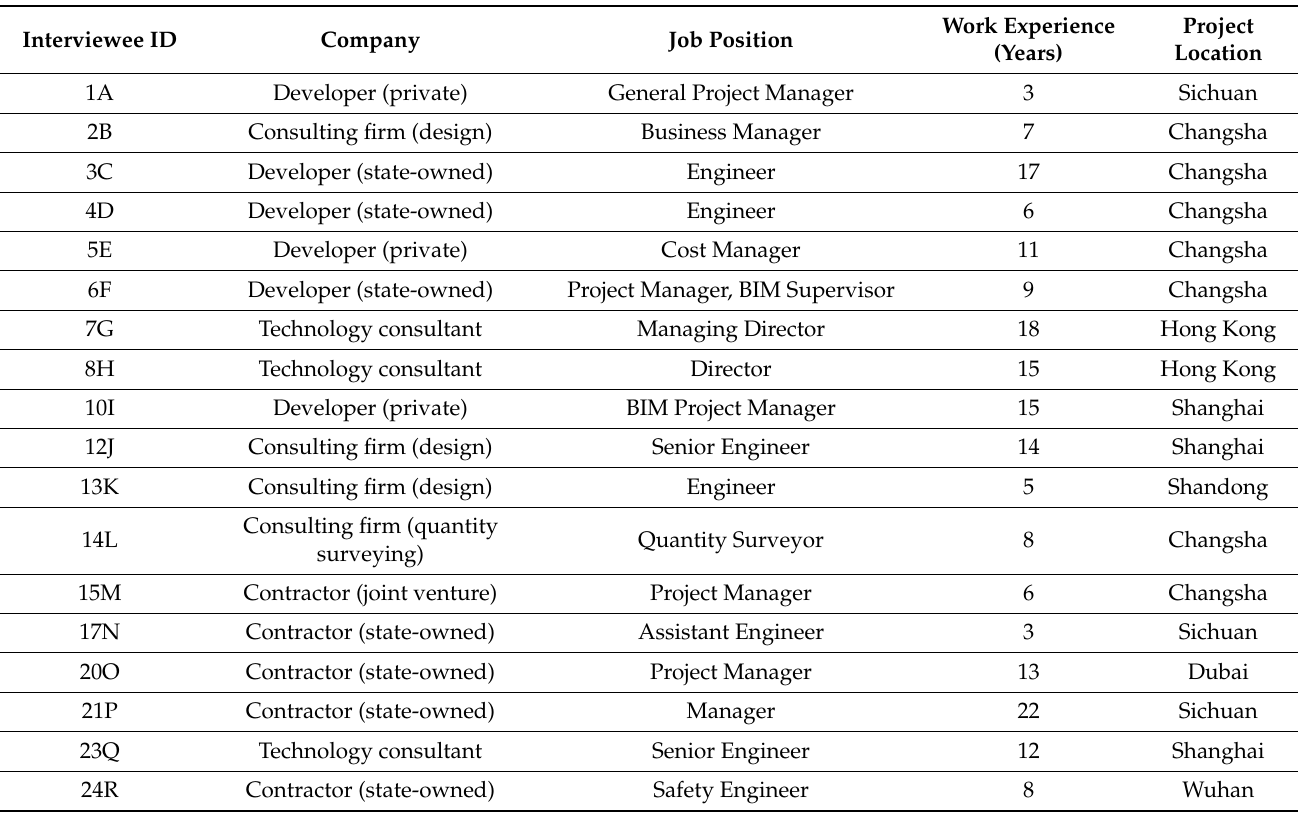
Table 1. Background information about the